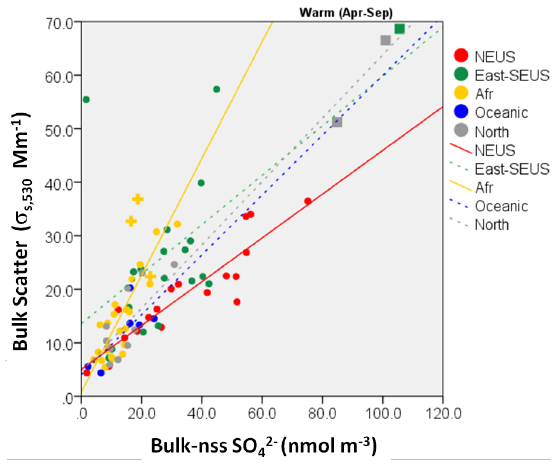
Fig. 6. Sectored bulk σ s , 530 versus bulk nss SO 2 − each of the source region flow patterns during the warm season; color-coded lines depict the corresponding regressions. Regression statistic for the solid lines (NEUS and AFR + outliers) are reported in Table